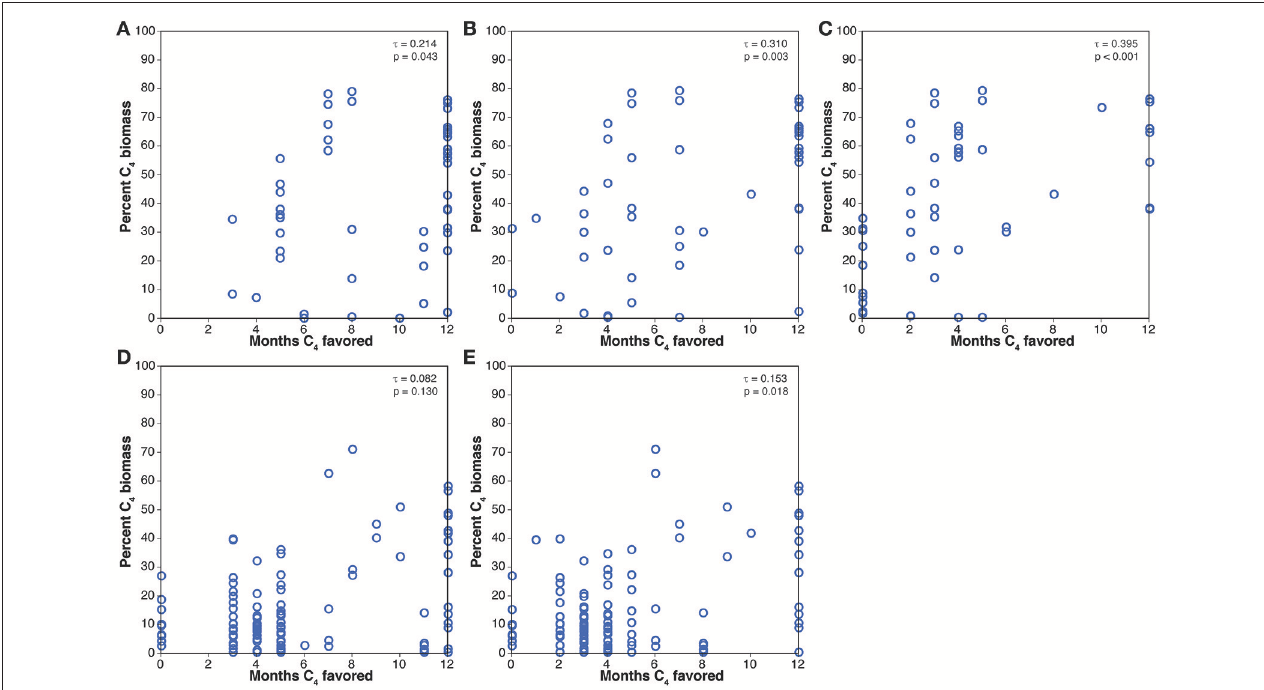
FIGURE 5 | Comparisons of results of the crossover temperature model to mean estimated percent C 4 biomass from the biomineral compilation. (A) Pliocene, 280 ppmV CO